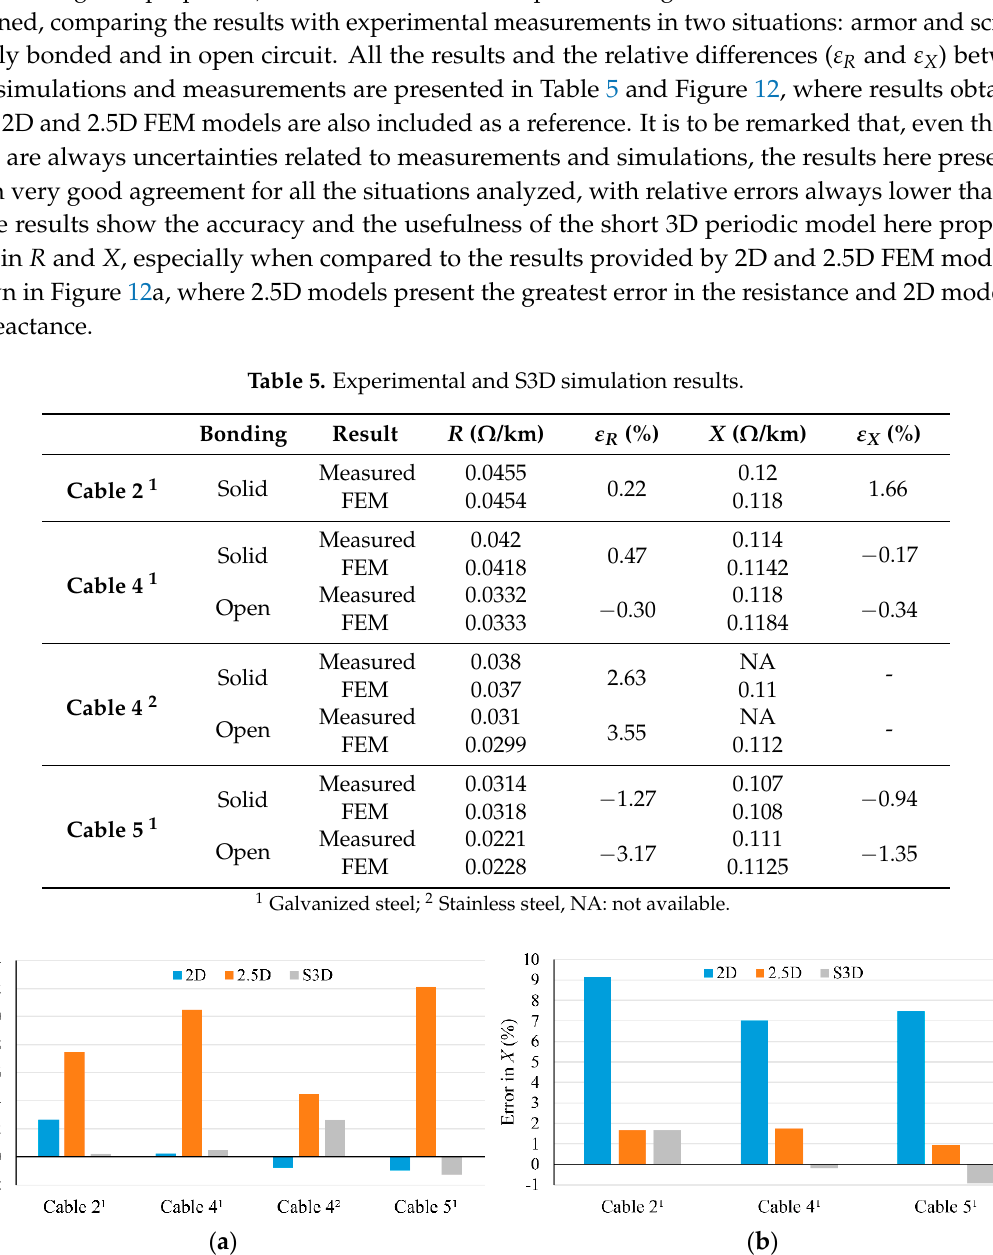
Figure 12. Errors in different FEM models for R ( a ) and X ( b ) relative to experimental measurements (solid bonding) for the cables of Table 5.